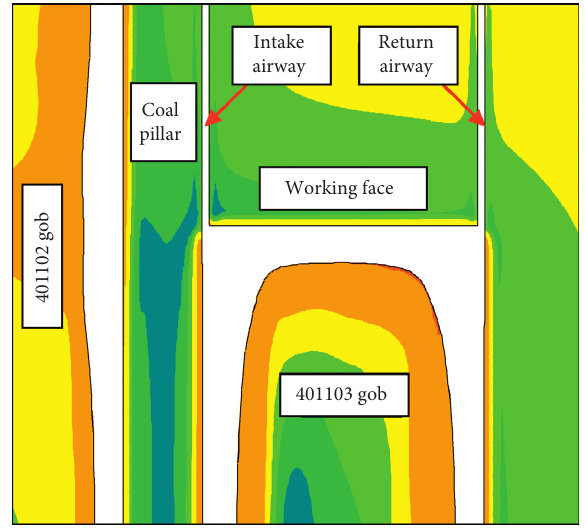
Figure 4: Vertical stress contour during mining.